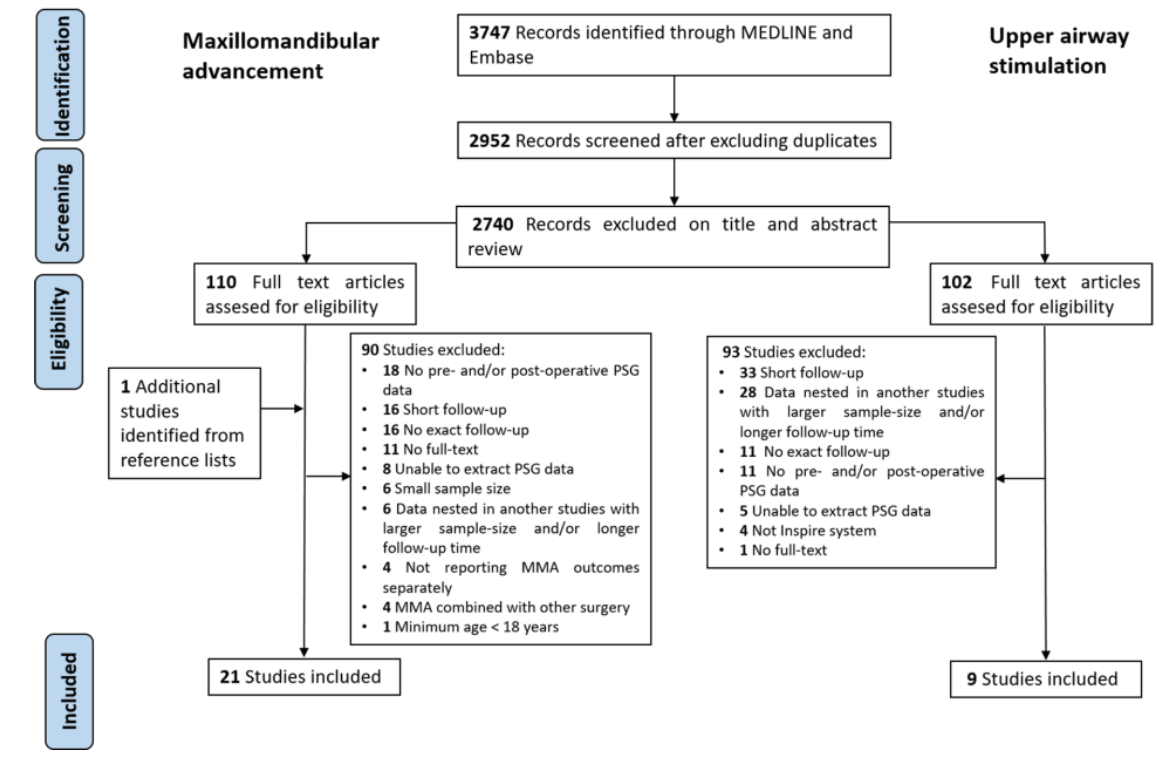
Figure 1. PRISMA flow diagram of the study selection process.